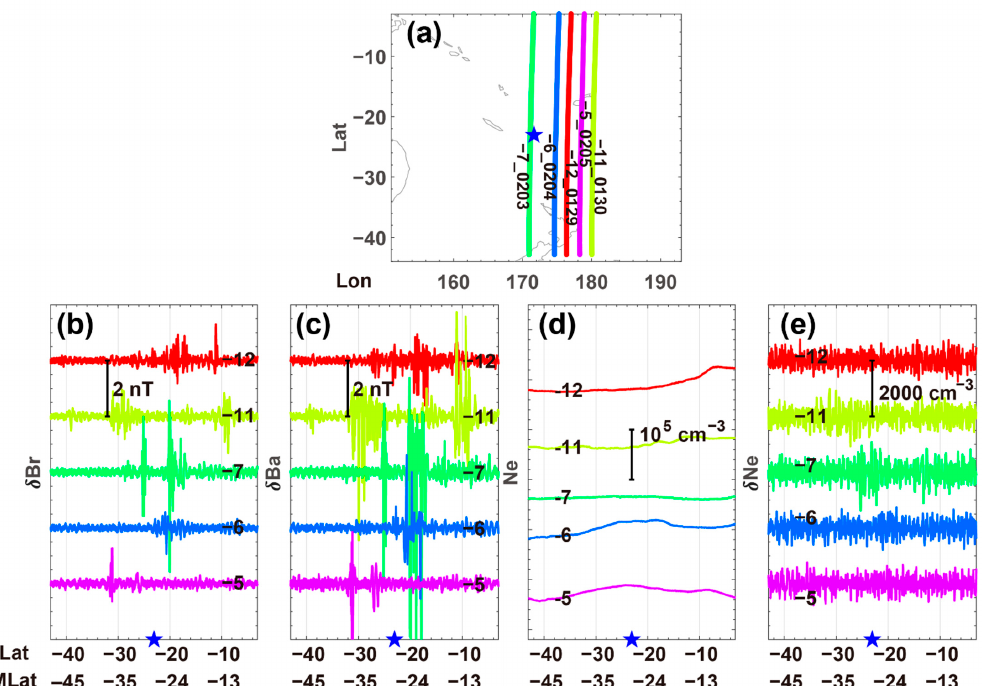
Figure 3. After removing the main influences of solar wind and SYM-H, a comparison between magnetic disturbances and electron density (Ne) was performed. ( a ) Swarm B orbits with magnetic disturbances (LT~17). The blue star indicates the epicenter. Numbers around orbits show time differences ( ∆ T in days) and the date of each orbit; ( b , c ) residual magnetic field in Br and Ba; ( d ) original Ne; ( e ) residual Ne.